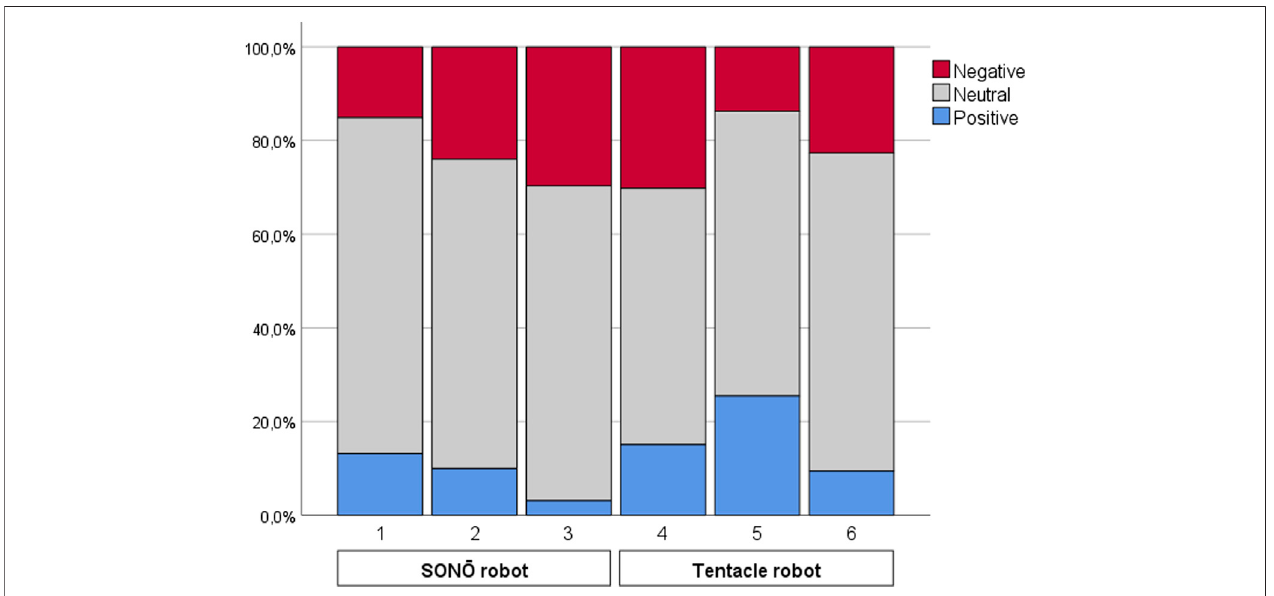
FIGURE 6 | Stacked bar graph showing proportional distributions of positive, neutral, and negative sentiment words.